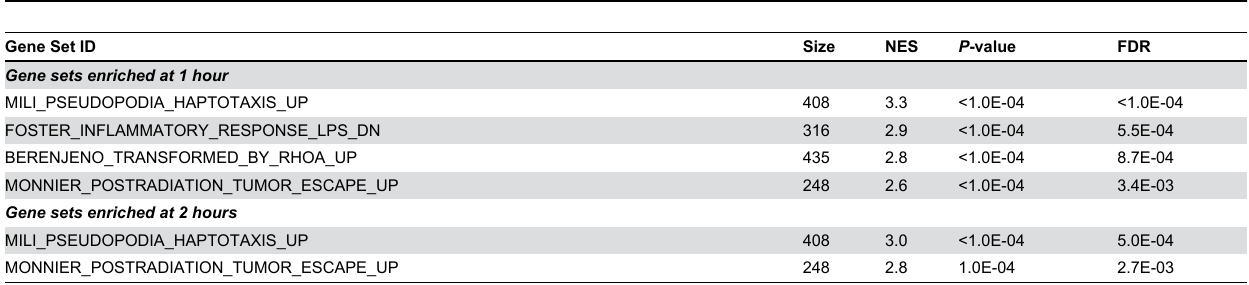
Table 1. Gene set enrichment analysis of the change of gene expression profiles in response to lysophosphatidic acid (LPA)